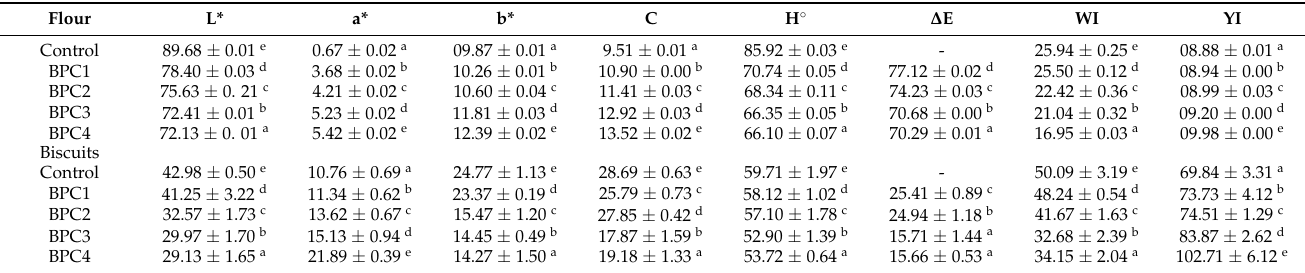
Table 3. Colour attributes for composite flours and